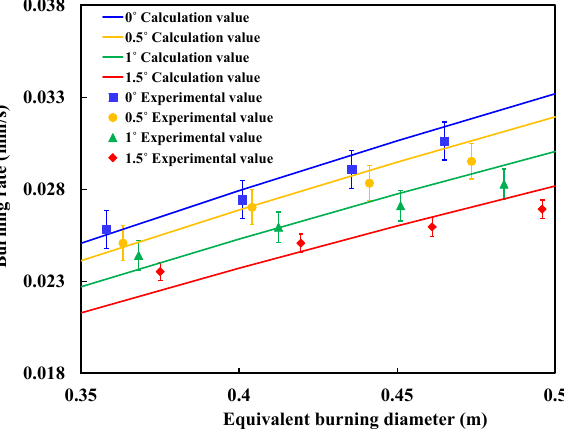
Figure 14. Variation of burning rate ratio of spill fire with slope.